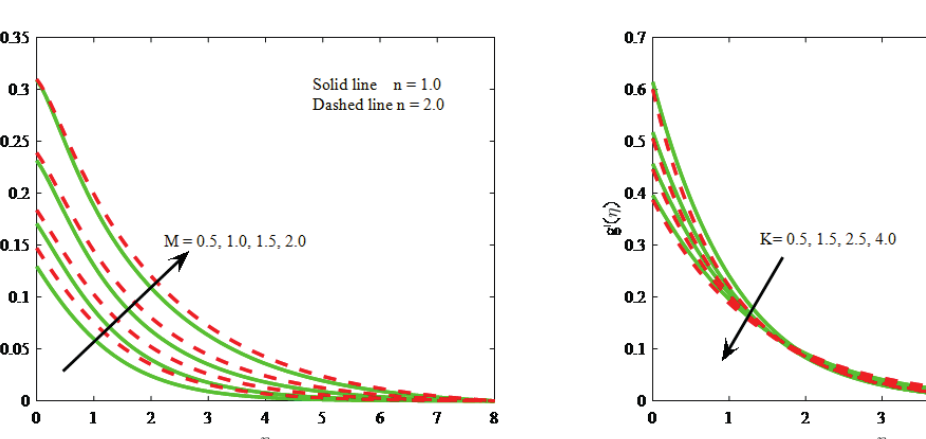
Fig. 4: Impact of M on temperature.